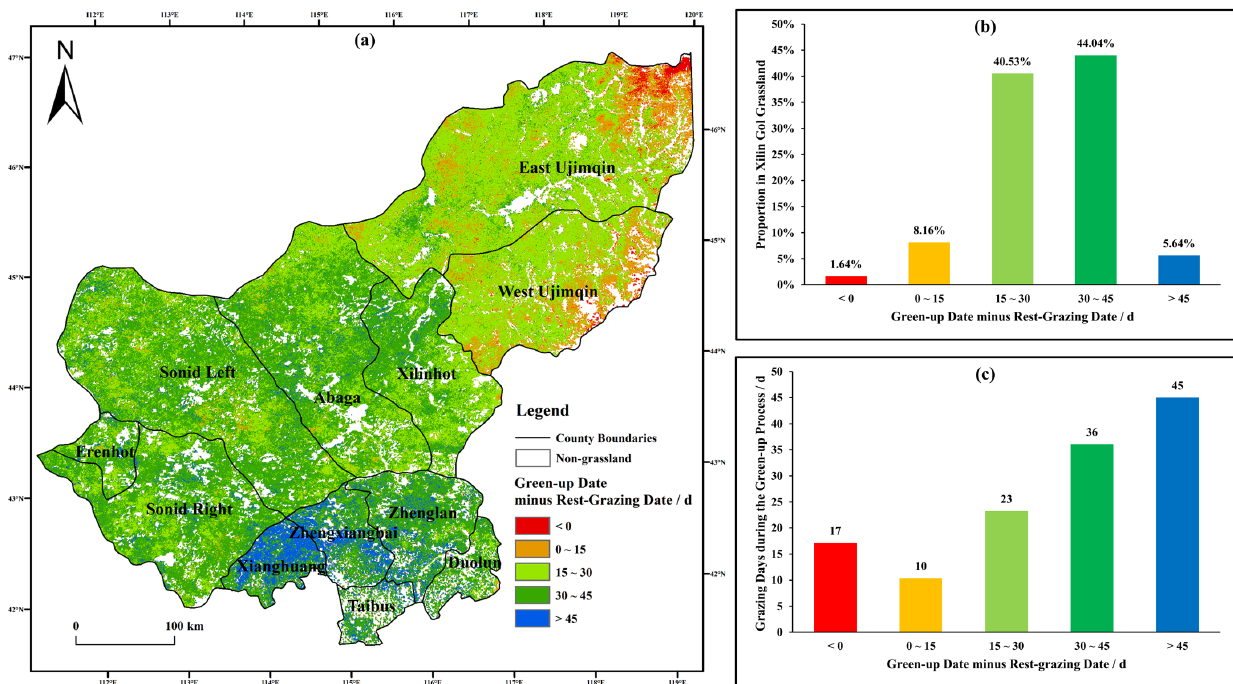
Figure 6. ( a ) Spatial distributions of the gap between green-up date and rest-grazing date; ( b ) area proportions of grasslands with different gaps between the two dates; ( c ) grazing days during the green-up process in the grasslands with different gaps between the two dates.